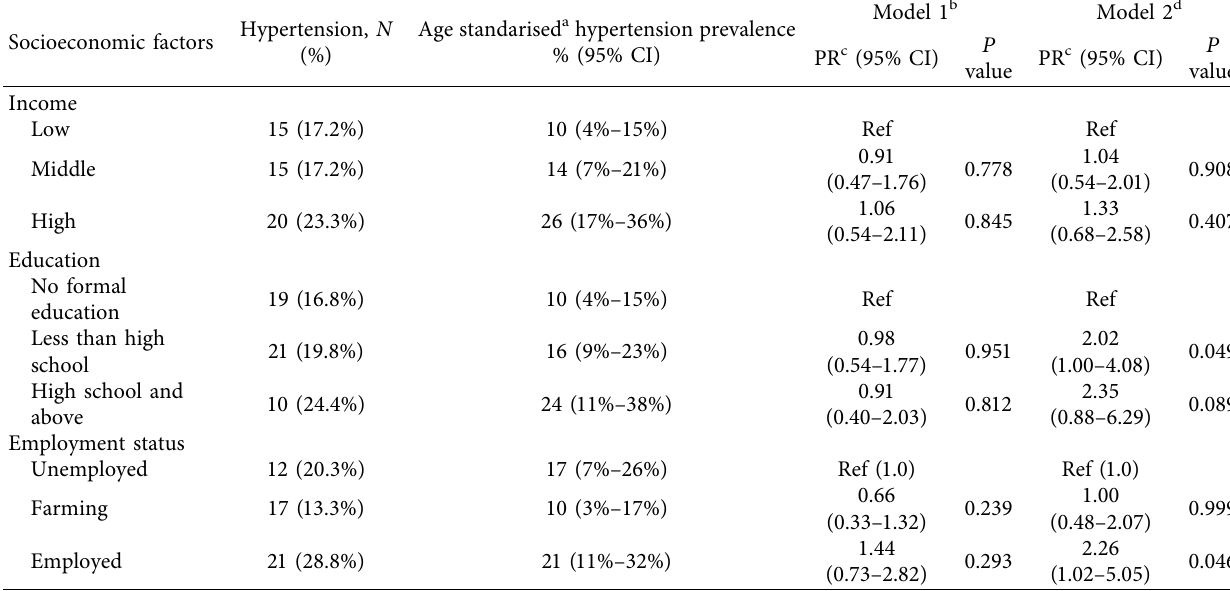
Table 2: Relationship between socioeconomic status and